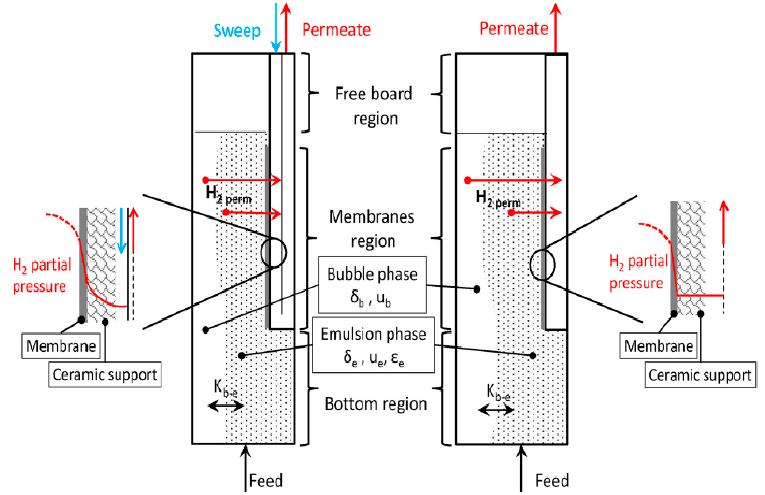
Figure 1. Scheme of the fluidized bed membrane reactor developed in ACM with and without gas for PSS and ceramic supports [16] .